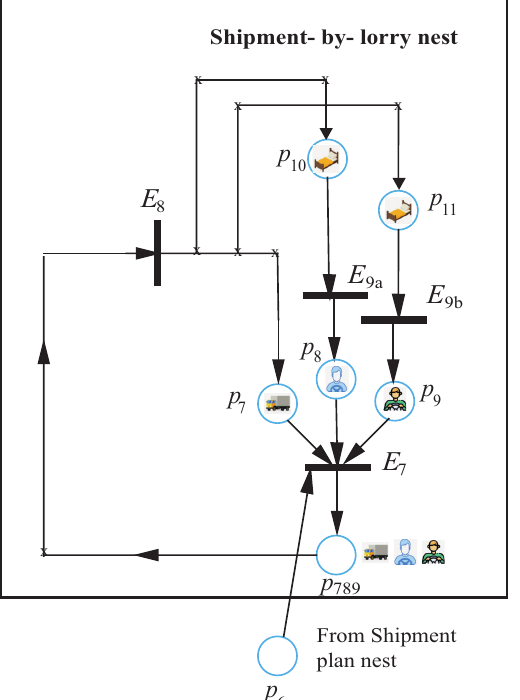
Figure 8. Hierarchical modeling of the courier example: shipment-by-lorry.